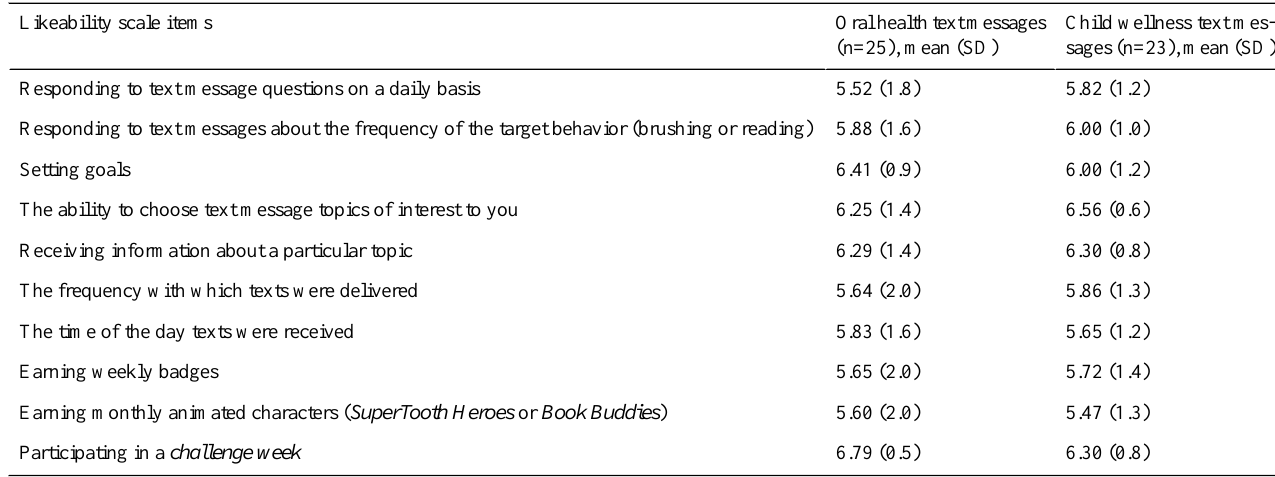
Table 3. Likeability of the text message